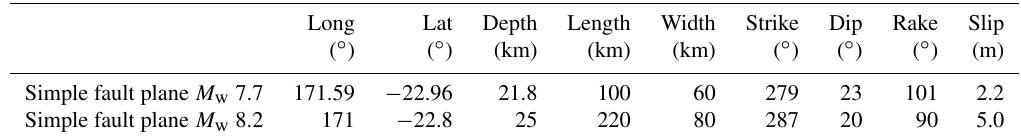
Table 1. Parameters used for the initial deformation calculation associated to uniform slip ruptures corresponding to M w 7.7 and M w 8.2 earthquakes. Long Lat Depth Length Width Strike Dip Rake Slip ( ◦ ) ( ◦ ) (km) (km) (km) ( ◦ ) ( ◦ ) ( ◦ ) (m) Simple fault plane M w 7.7 171.59 − 22.96 21.8 Simple fault plane M w 8.2 171 − 22.8 220 287